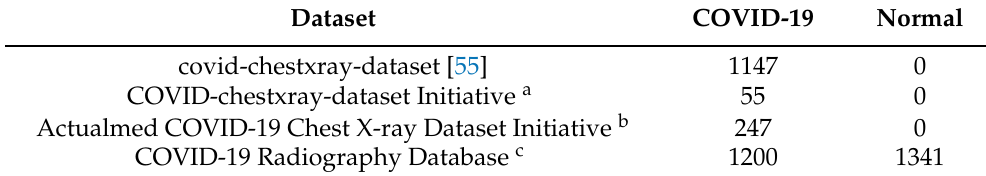
Table 1. A summary of the datasets that were used in this